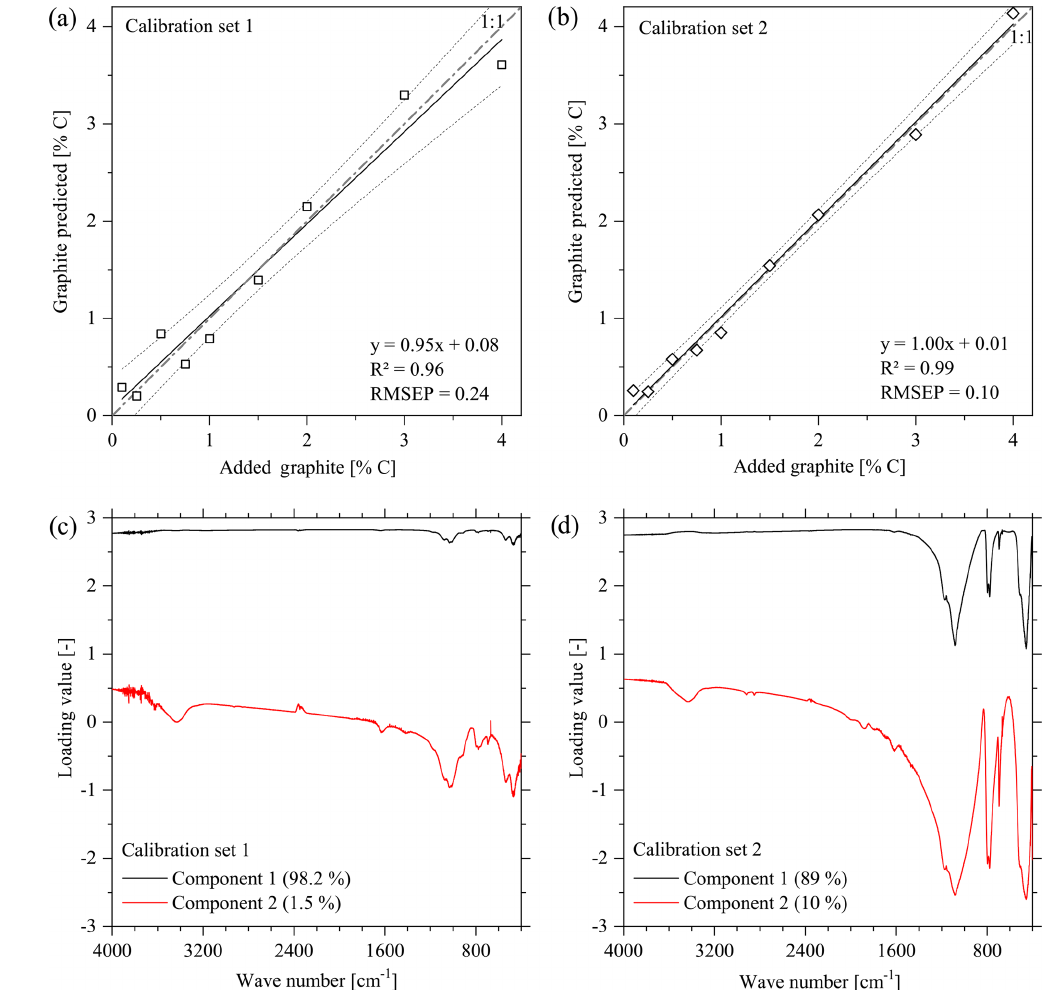
Figure 1. Prediction plots with 95% prediction bands (a, b) and loading plots (c, d) after FTIR analyses of the PLSR calibration sets using soil (calibration set 1) and pure quartz (calibration set 2) with graphite concentrations of 0.1%–4% added as indicated in Table